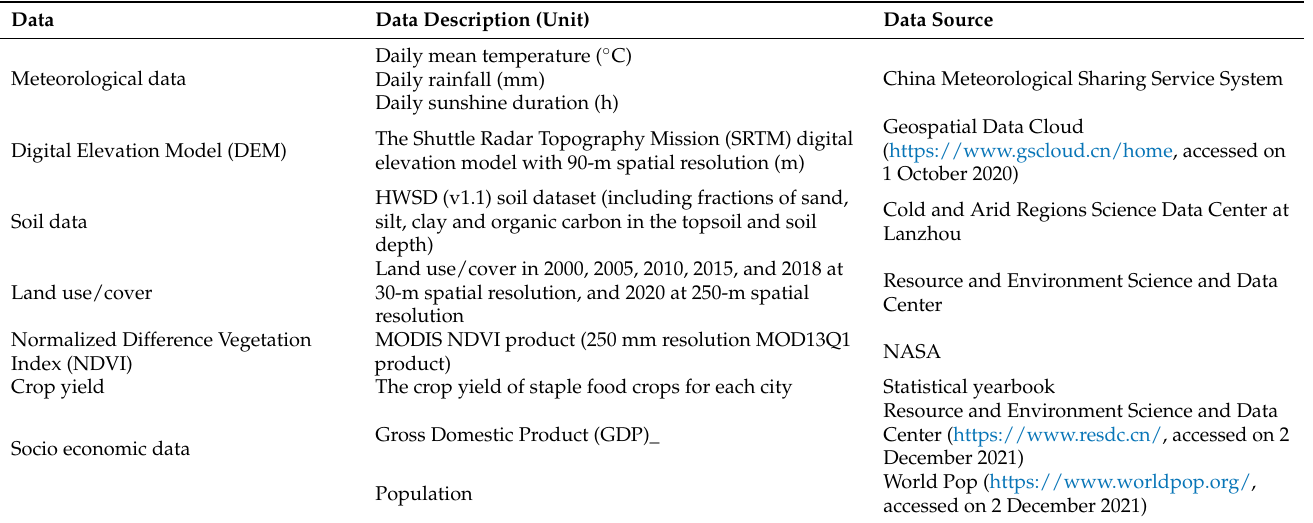
Table 1. Description of the data used in this